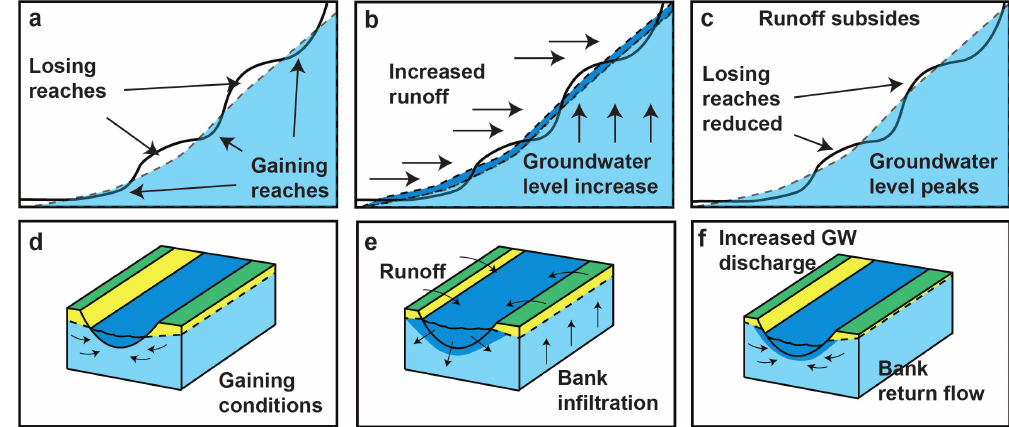
Fig. 13. Schematic representation of the Tambo River profile (solid line), water table (dashed line/light blue shading) and runoff (dark blue shading) under baseflow conditions (a) , high-flow conditions (b) and receding conditions (c) . River cross sections shown in (d) , (e) and (f) for baseflow, high flow and recession,